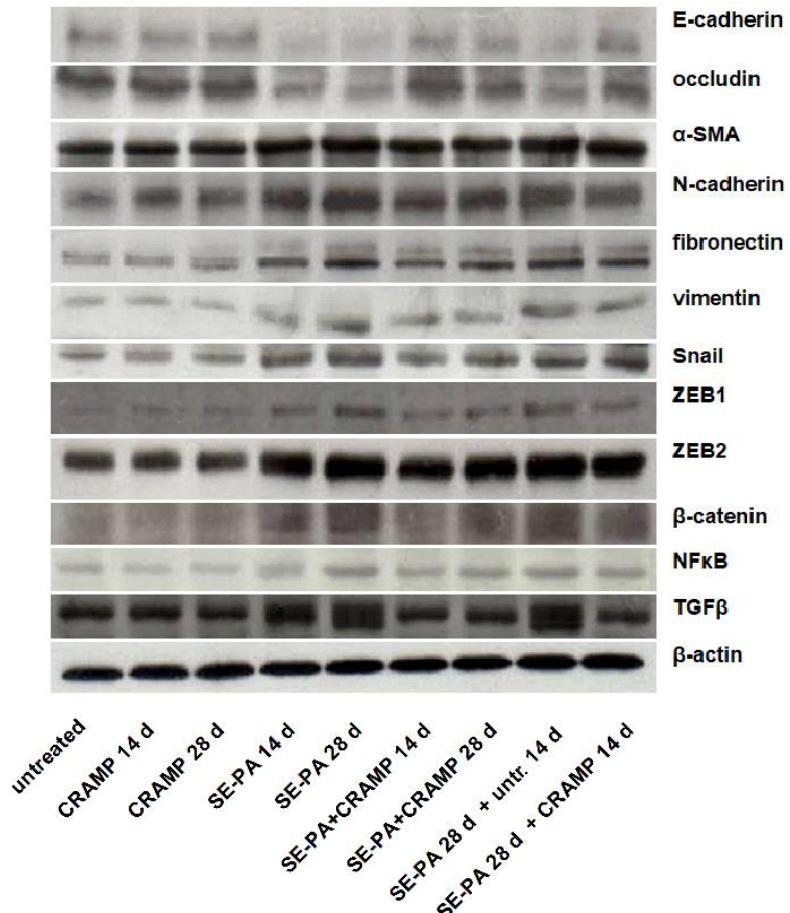
Figure 2. Alterations in the expression of proteins involved in epithelial–mesenchymal transition (EMT) in response to cathelicidin (CRAMP) and/or saline extract of Pantoea agglomerans (SE-PA) treatment. Protein expression was investigated in homogenates of lungs collected from untreated mice (control) and animals exposed to investigated compounds for 14, 28, or 42 days using the Western blotting method. Examination of ß-actin expression level was used as the internal control. Representative Western blots with densitometric analyses of epithelial markers, mesenchymal markers, and factors involved in epithelial – mesenchymal transition. Results of the densitometric analysis are presented as the mean of protein expression ± SD. Each research group consisted of 8 mice: 6 treated and 2 untreated animals. Samples collected from animals belonging to the common research group were mixed in equal volumes and then analyzed in 3 replications. Statistical significance from one-way ANOVA test followed by Tukey’s post hoc test: compared to untreated mice at p < 0.05 (*), p < 0.01 (**), p < 0.001 (***); SE-PA + CRAMP 14 d/28 d vs. SE-PA 14 d/28 d (comparison within corresponding time points) at p < 0.01 (##), p < 0.001 (###); SE-PA 28 d + CRAMP 14 d vs. SE-PA 28 d + untreated 14 d at p < 0.01 (^^), p < 0.001 (^^^).